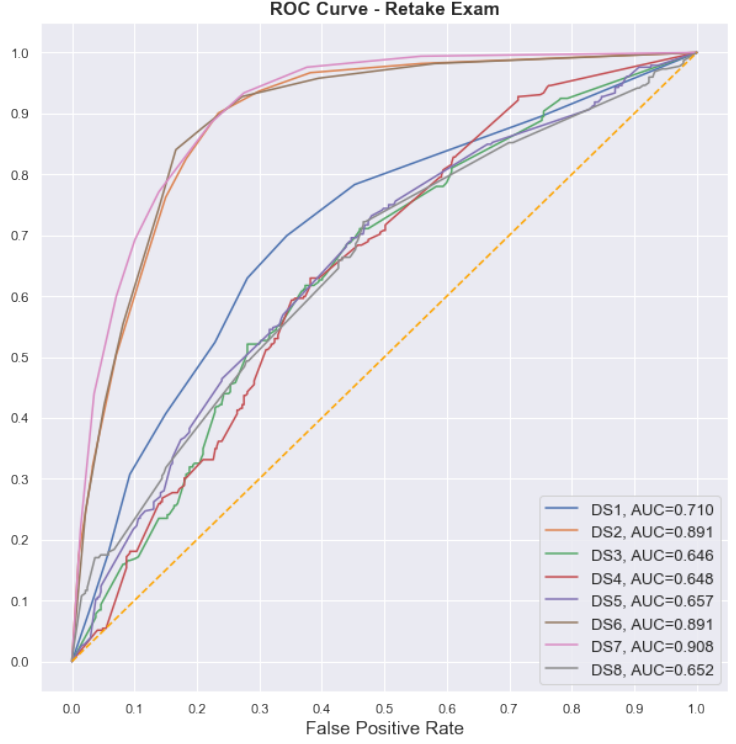
Figure 11. ROC Success in the exam. Table 6. Predicting success in retaking the exam versus failure. DS